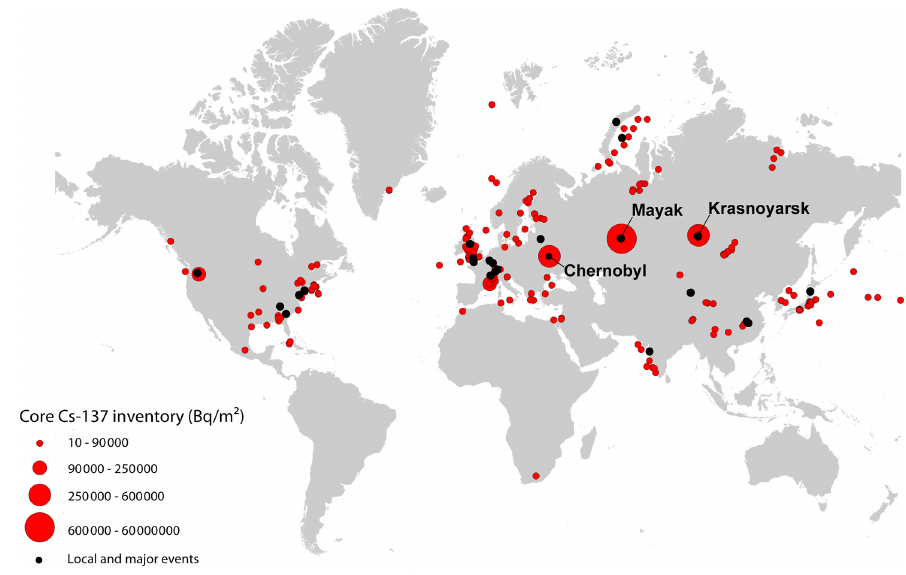
Figure 6. 137 Cs inventory in the sediment cores covered in the database and location of some of the main sources of 137 Cs.